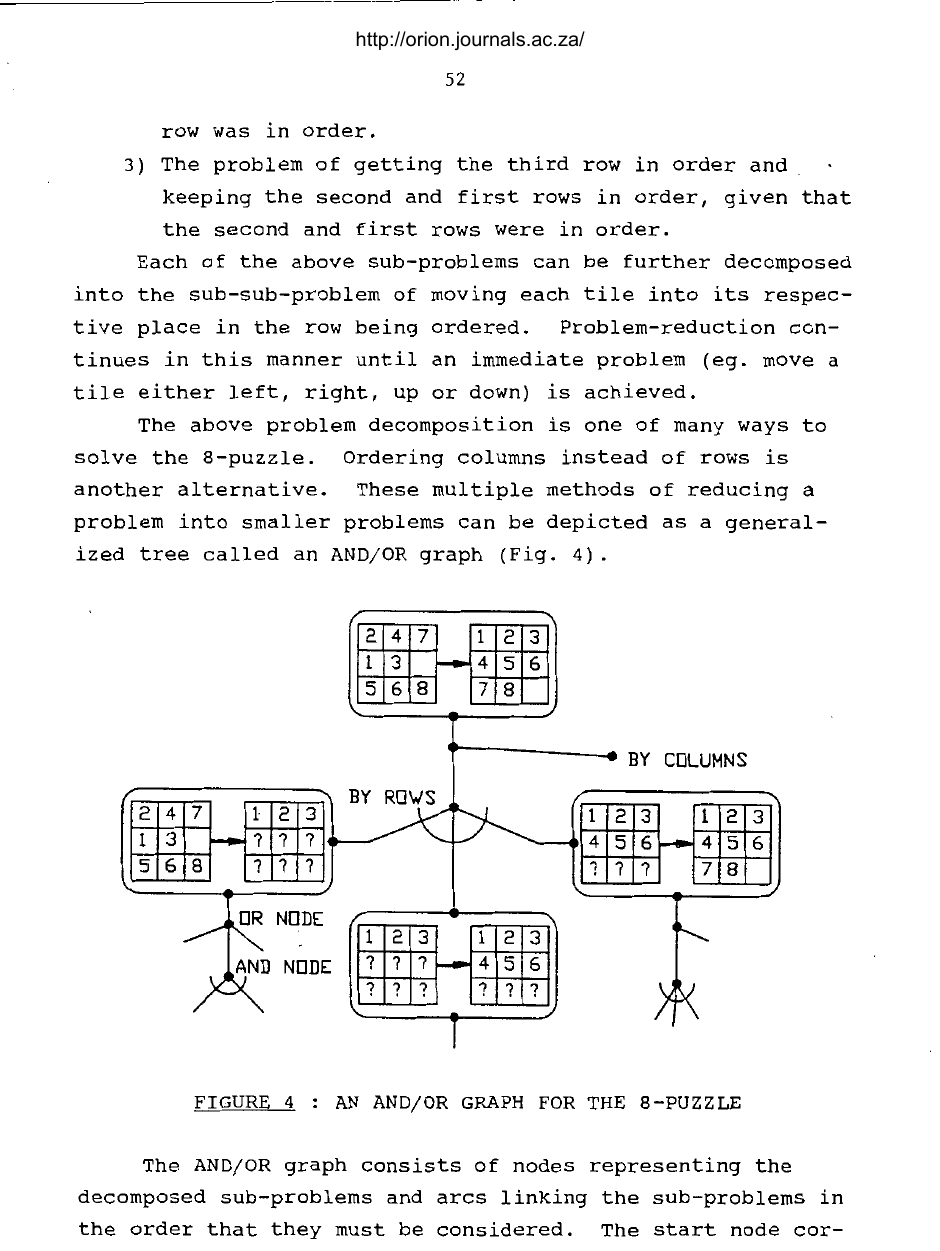
FIGURE 4 : AN AND/OR GRAPH FOR THE 8-PUZZLE The AND/OR graph consists of nodes representing the decomposed sub-problems and arcs linking the sub-problems in the order that they must be